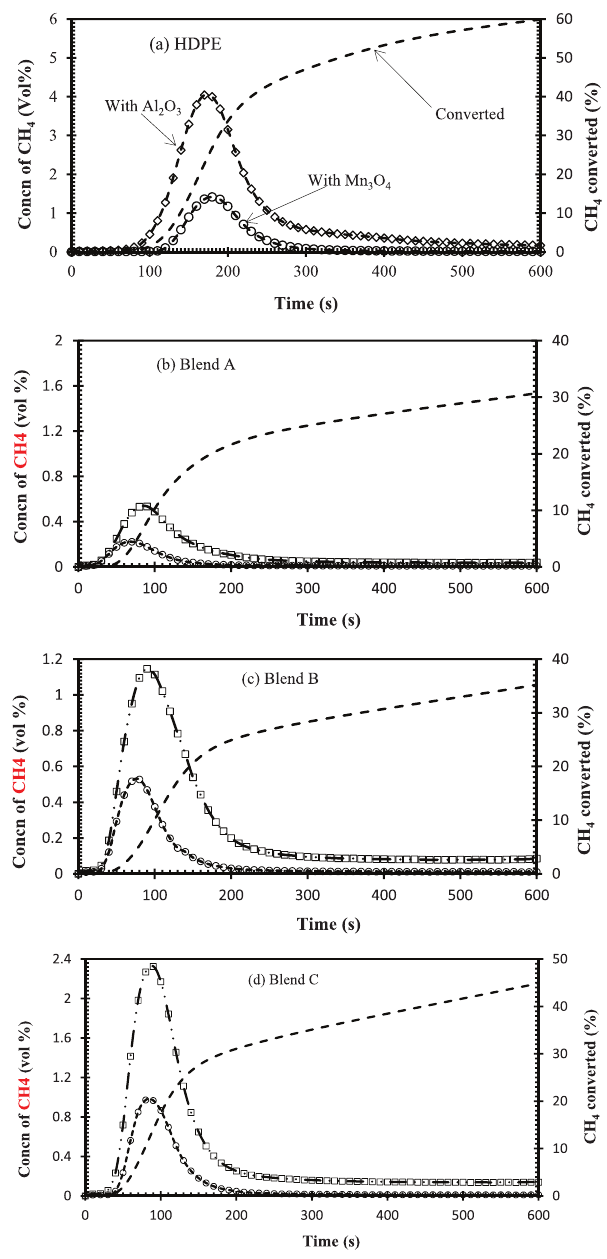
Fig. 10: Concentration of CH 4 generated after heating HDPE/ coke-Al 2 O 3 and HDPE/coke-Mn 3 O 4 compacts at different C/O ratios at 1150 °C; along with % CH 4